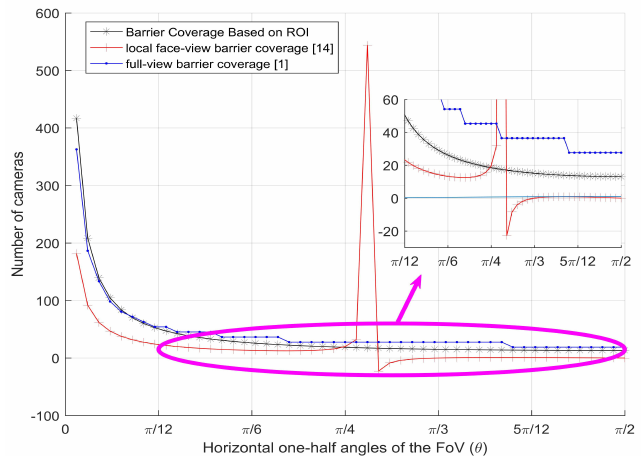
Figure 11. Number of camera sensors per 100 m vs. the effective horizontal angle for different barrier coverage strategies.